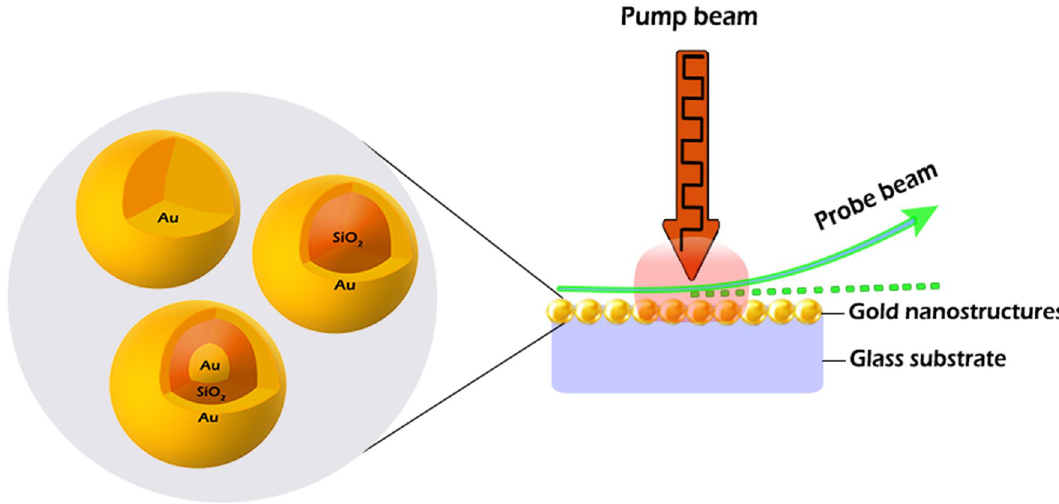
Figure 6. Different types of Au nanostructures; Au nanosphere, SiO 2 –Au core–shell and Au–SiO 2 –Au nanomatryoshka structures used for modifying the substrate.